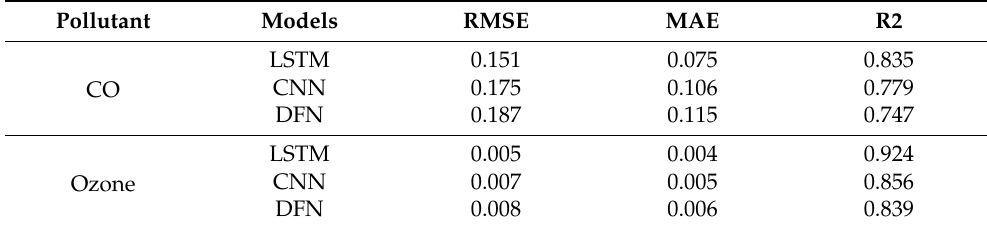
Table 5. Comparison of forecasting models evaluation results based on meteorological station data (created by